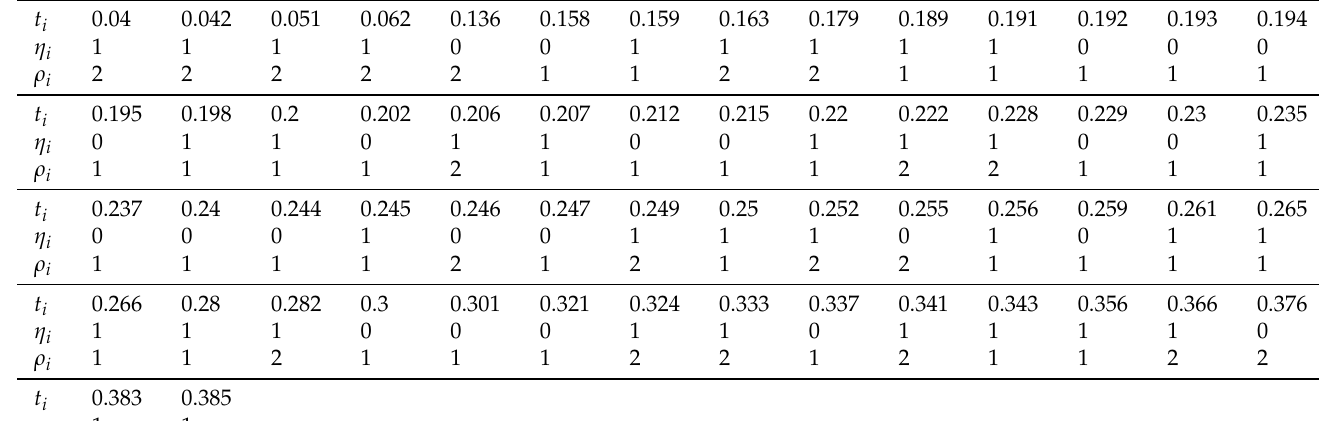
Table 6. Jointly type-II GHCS competing risks sample from Hoal data with m = 50.